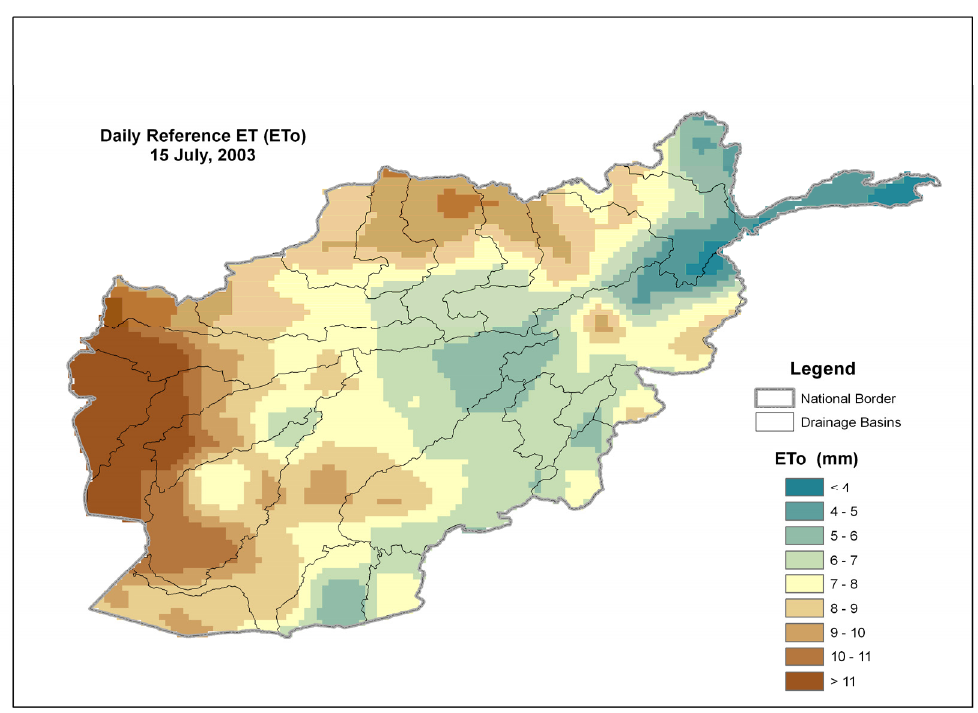
Figure 4. Daily GDAS reference ET (ETo) at 10km resolution, downscaled from 1 degree resolution using the IWMI long-term average gridded